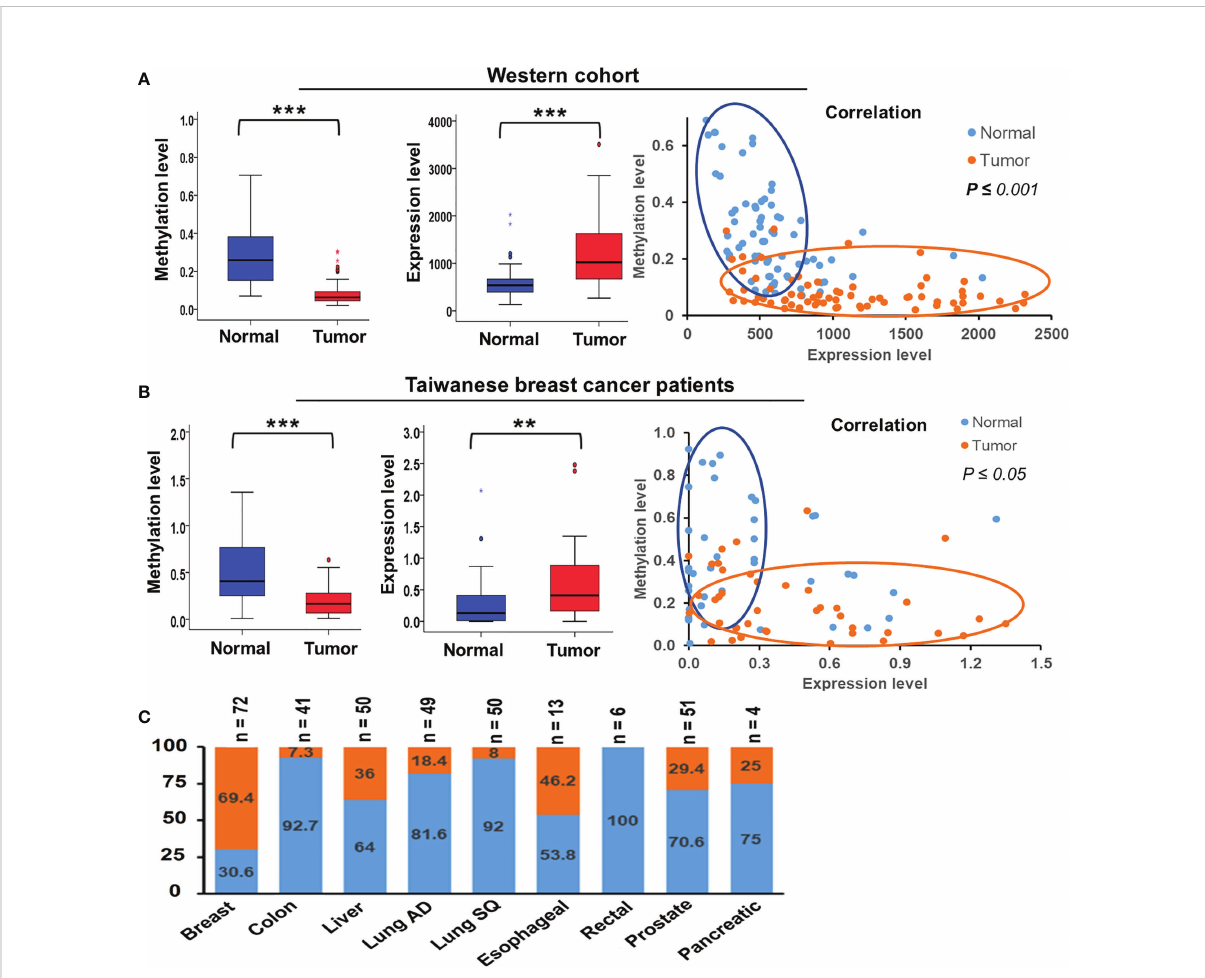
FIGURE 2 Methylation and expression of TSTD1 in breast cancer and in various cancer types. (A) DNA methylation level, mRNA expression level and the correlation between TSTD1 hypomethylation and overexpression in of tumor and adjacent normal tissues of the Western breast cancer cohort, analyzed from TCGA datasets. (B) DNA methylation level, mRNA expression level and the correlation between TSTD1 hypomethylation and overexpression in of tumor and adjacent normal tissues of Taiwanese breast cancer patients. (C) mRNA expression level of TSTD1 in various cancer types. The relationship was analyzed using Pearson X 2 test. ACTB and GAPDH were the internal controls for DNA methylation and mRNA expression, respectively. Data were analyzed using student ’ s paired t-test. * p ≤ 0.05, ** p ≤ 0.01, *** p ≤